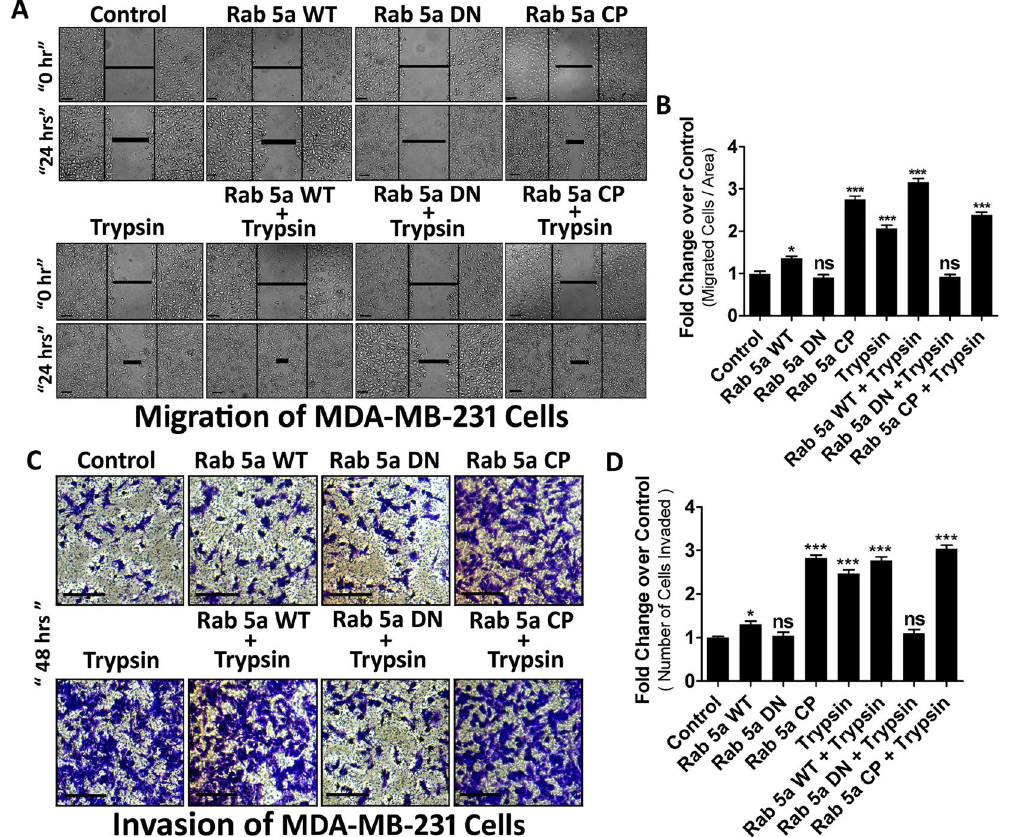
Figure 5. Trypsin Dependent Rab5a Activation Promotes Migration and Invasion of MDA-MB-231 Cells. Cells were transfected with Rab5a WT, Rab5a DN and Rab5a CP and incubated for 48 hours at the end of which serum starvation was given followed by trypsin addition. Migration potential of the cells were analyzed by wound healing assay as described briefly in methods and accordingly quantification was made by GraphPad Prism5 ( A ) and ( B ). Cells were treated with various Rab5a constructs and placed on top of a transwell membrane previously coated with matrigel in serum free media. Cells were treated with trypsin and the lower compartment is filled with complete media. Cells that were invaded through the membrane were fixed and stained with crystal violet solution. Images were taken and number of invaded cells was counted and quantified accordingly ( C ) and ( D ). Data presented over here are as Mean + / − S.E. of the Mean after performing the experiments at least thrice and differences are statistically significant at p < 0.05 using student’s t-test and ‘ns’ represents non-significant